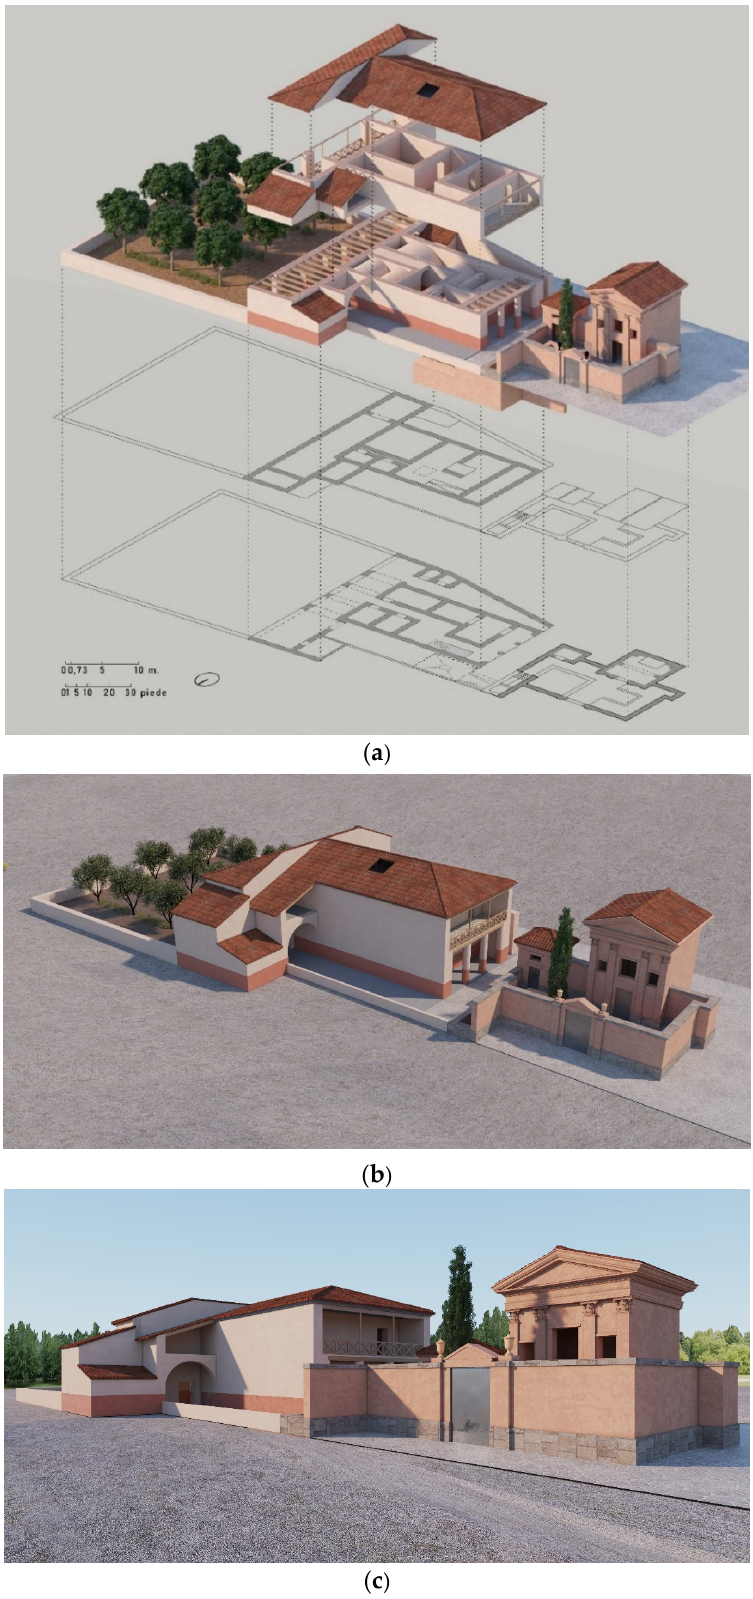
Figure 8. Reconstructive hypothesis of the monumental complex: ( a ) isometric exploded view of the rendered model; ( b , c ) different views of the rendered model.